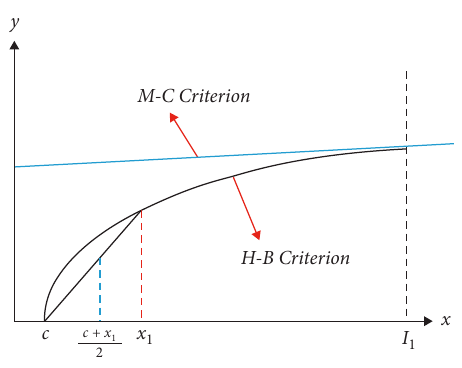
Figure 2: The optimal first-order